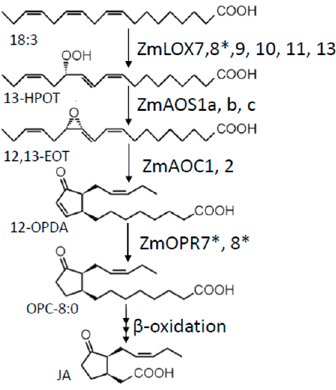
Figure 2. Overview of maize JA biosynthetic pathway. Genes marked with * have been functionally characterized [44,45] and other genes are predicted from phylogenic analysis.